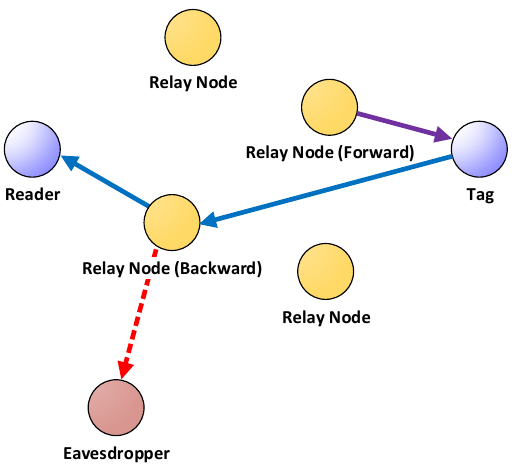
Figure 39. Secure BackCom assisted by helping